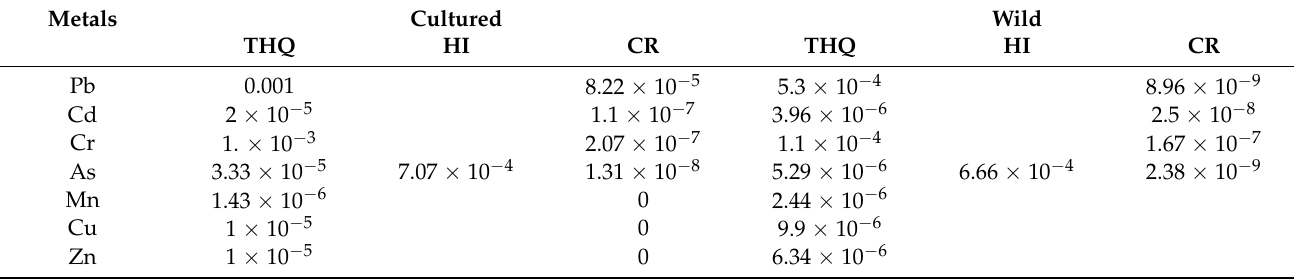
Table 6. Non-carcinogenic (THQ) and carcinogenic risk (CR) of metals of the cultured and wild